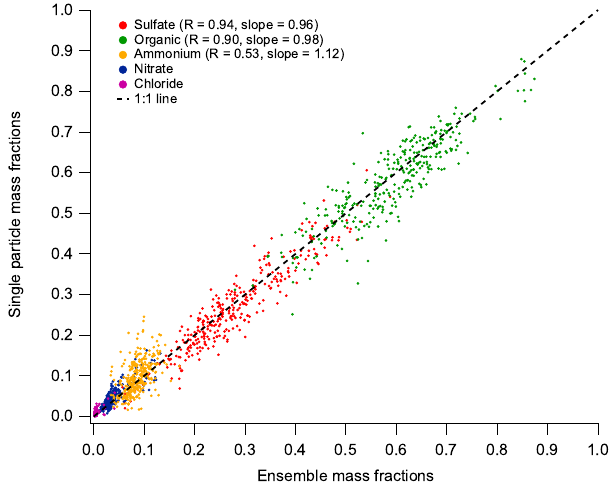
Figure 7. Organic (green), sulfate (red), ammonium (yellow), ni- trate (blue), and chloride (purple) mass fractions from single- particle measurements vs. ensemble measurements from